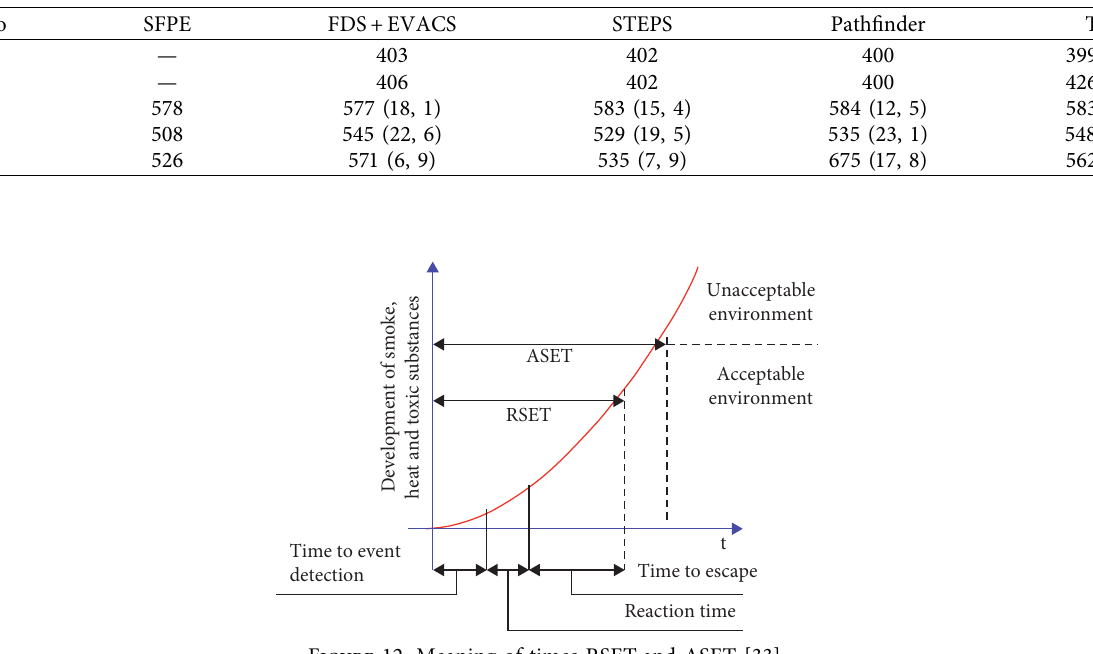
Table 2: Results of comparison of evacuation models.